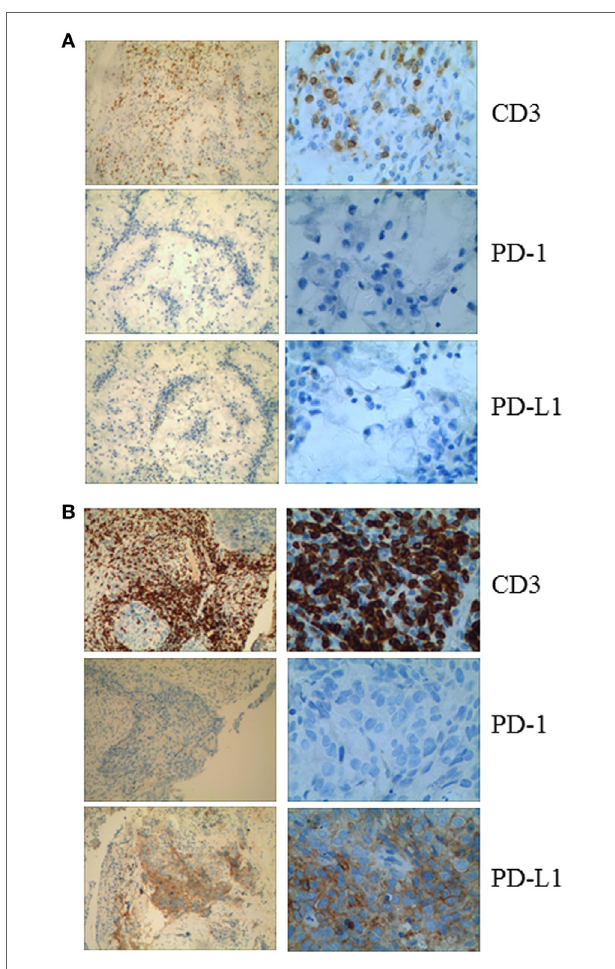
FIgURe 2 | (a) Immunohistochemical analysis in Patient 1 shows no membranous expression of programmed cell death-1 or PD-L1 in the tumor cells and the small background cells surrounding the malignant tumor cells. CD3 + cells are observed among the tumor cells. (B) Immunohistochemical analysis of a pretreatment tumor in Patient 2 shows focal membranous expression of PD-L1 in the tumor cells, with additional expression seen on the small background cells surrounding the malignant tumor cells. Abundant CD3 + cells are identified among the tumor cells (magnification: left panel, 10 × ; right panel, 40 ×